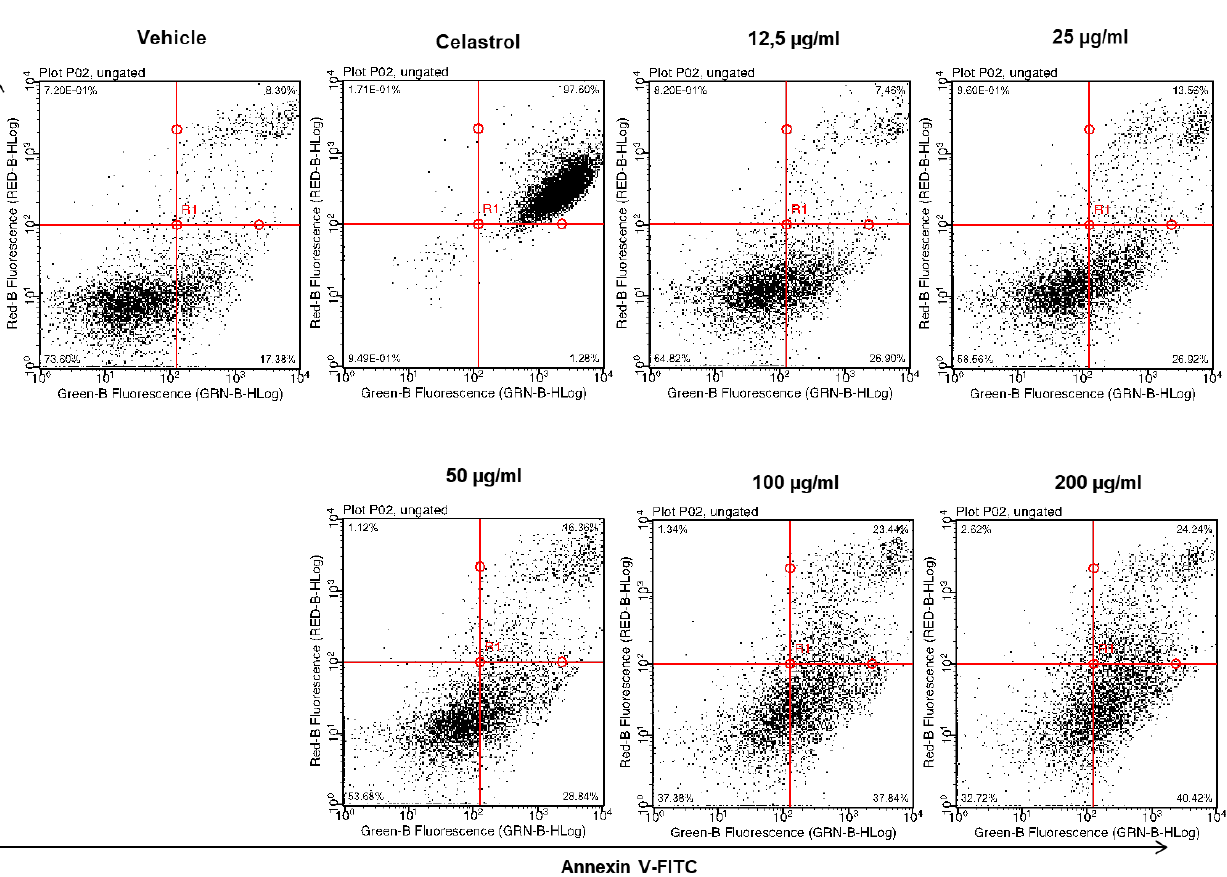
Figure 4. Dose-dependent induction of apoptosis by EHA-Aq fraction (12.5–200 µ g/mL) on MCF-7 cell line after 24 h of treatment. Celastrol inducing a 99% apoptotic response was used to delimit the quadrant determining apoptotic states.